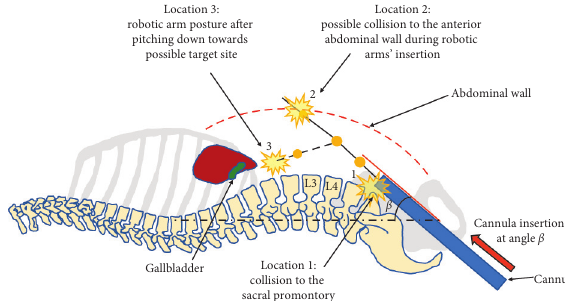
Figure 2: Possible collision sites for NOTES